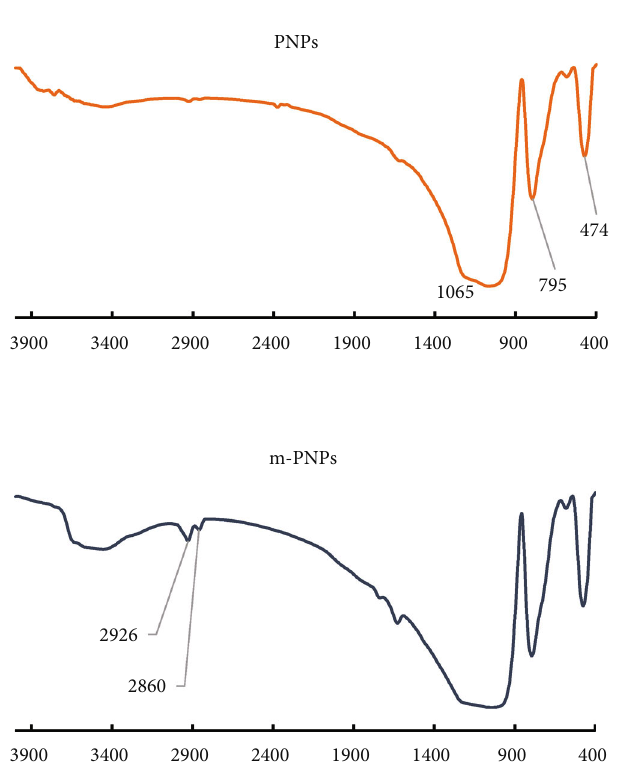
Figure 10: PNPs and m-PNPs FTIR (Figure 7). The intensity of peek in the UCO spectrum at 3003 cm − 1 corresponded to C – H of alkene was decreased and disappeared in the EUCO spectrum, accompanied by appearing a peek at 845 cm − 1 corresponded to oxirane ring.